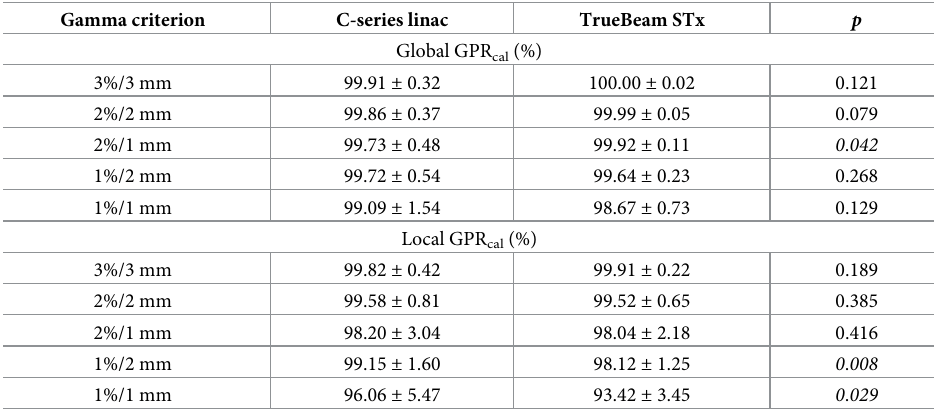
VMAT: Volumetric modulated arc